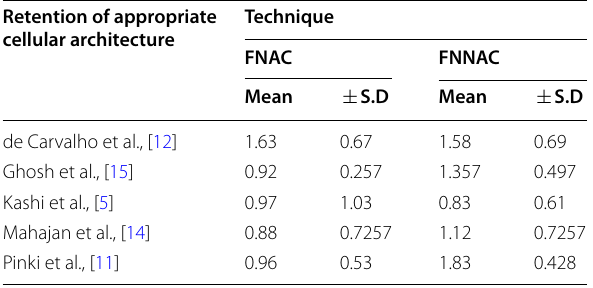
Table 12 Comparison between different studies regarding the retention of the appropriate cellular architecture using FNAC vs FNNAC [10] Retention of appropriate cellular architecture